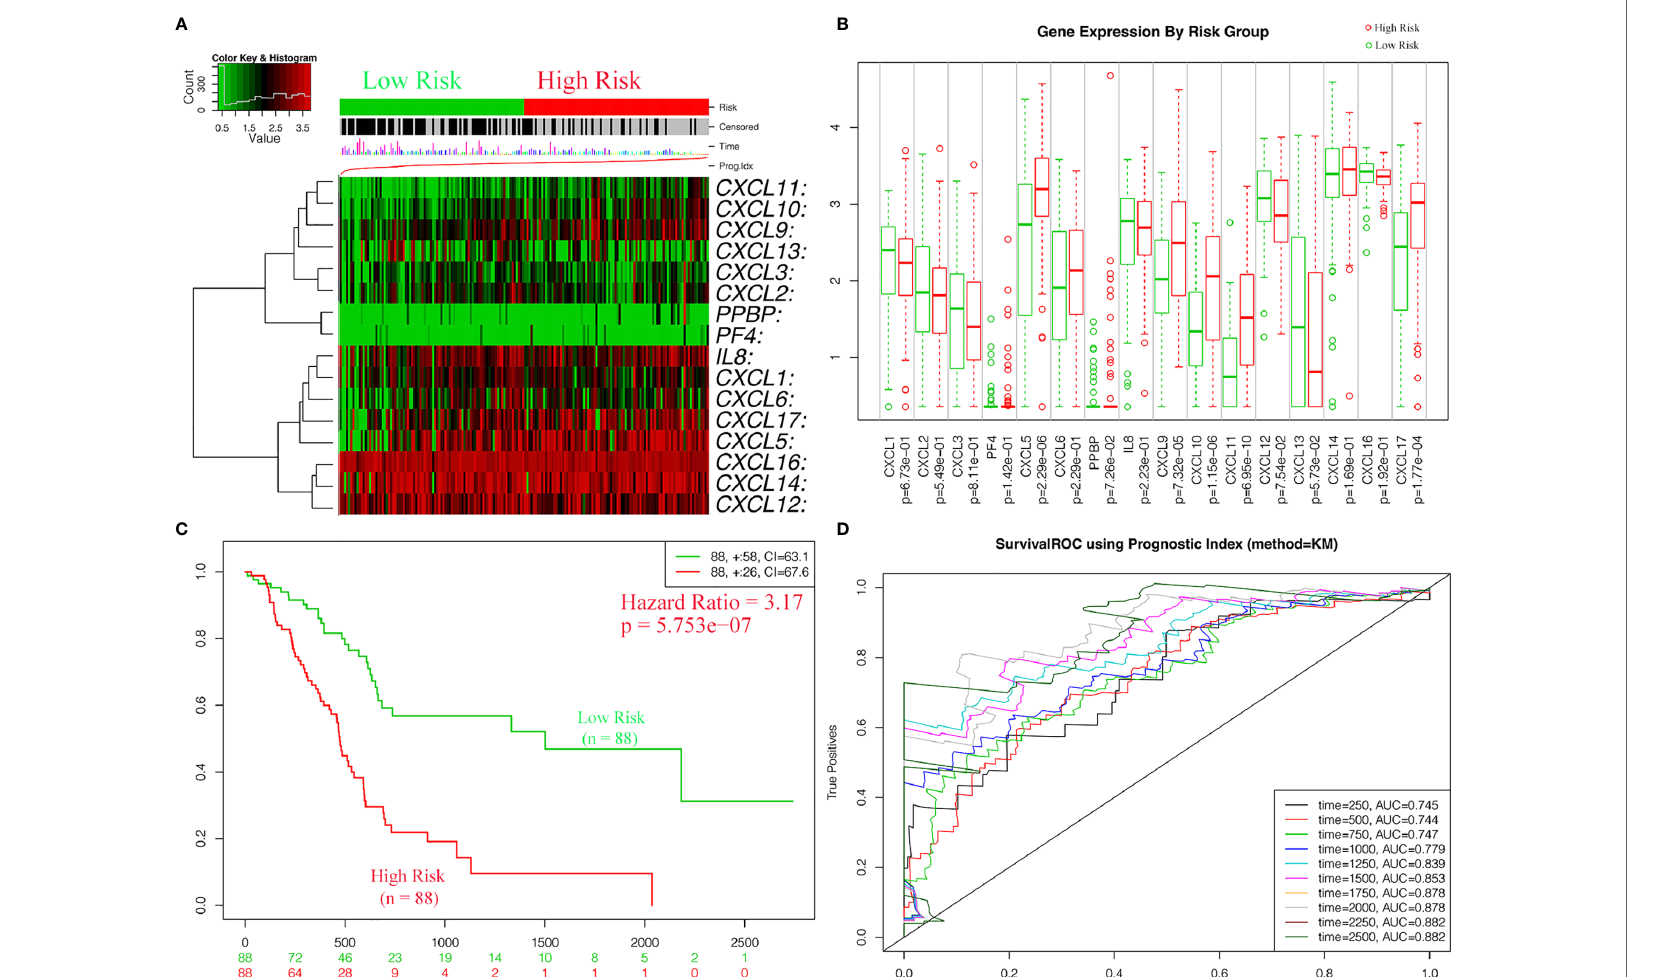
FIGURE 11 | The expressions levels and prognostic values of CXC chemokine signature in the training cohort (SurvExpress). (A) The heatmap of CXC chemokines in PAAD patients in the high- and low-risk group. (B) The expression levels of CXC chemokines between high- and low-risk groups. (C) Kaplan – Meier curves for survival analysis of CXC chemokines between high- and low-risk groups. (D) The survival ROC curves for survival prediction by the CXC chemokines assessed the accuracy of the prognostic